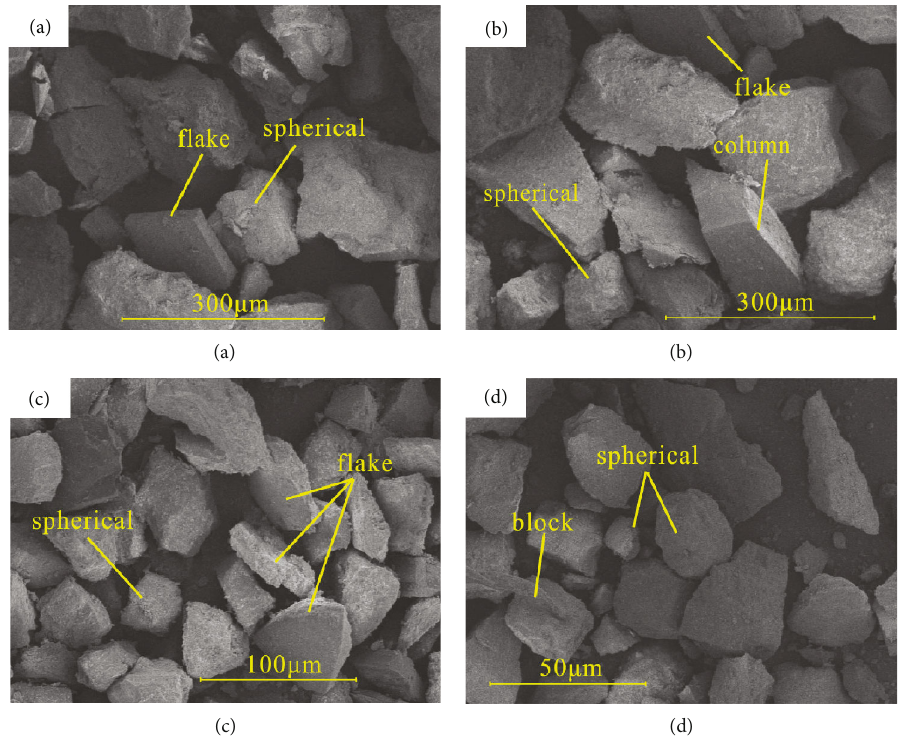
Figure 6: The morphology characteristic of coal fi nes by